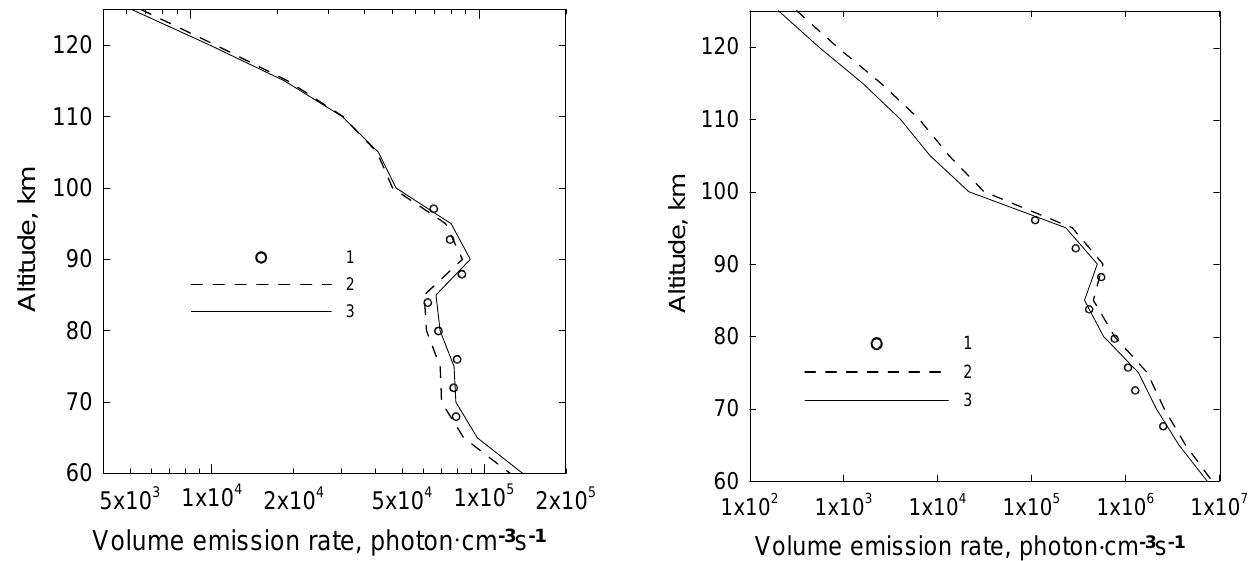
Fig. 8. Volume emission rate at 1.27 µ m. Circles (1) – experimental data of METEORS (Mlynczak et al., 2001). Curves – calculations for the conditions of experiment METEORS: 2 – in accordance with the model of Mlynczak et al. (1993); 3 – in accordance with our